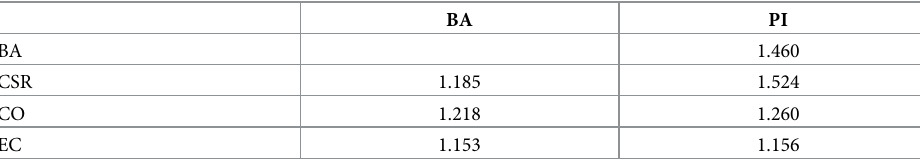
Table 5. Variance inflation